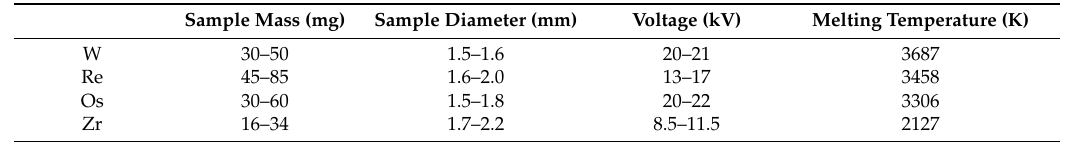
Table 1. Typical sample size and applied voltage for levitation.